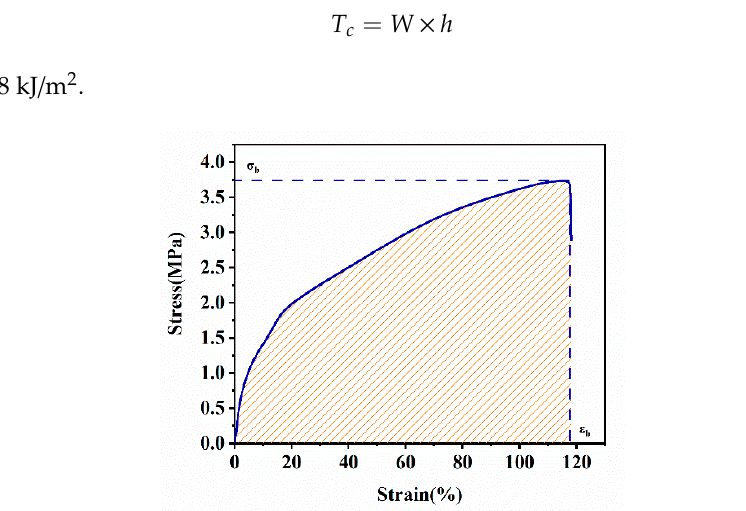
Figure 5. Force-displacement curve of the ethylene propylene diene monomer (EPDM) rubber composite under nicked angle tear test.